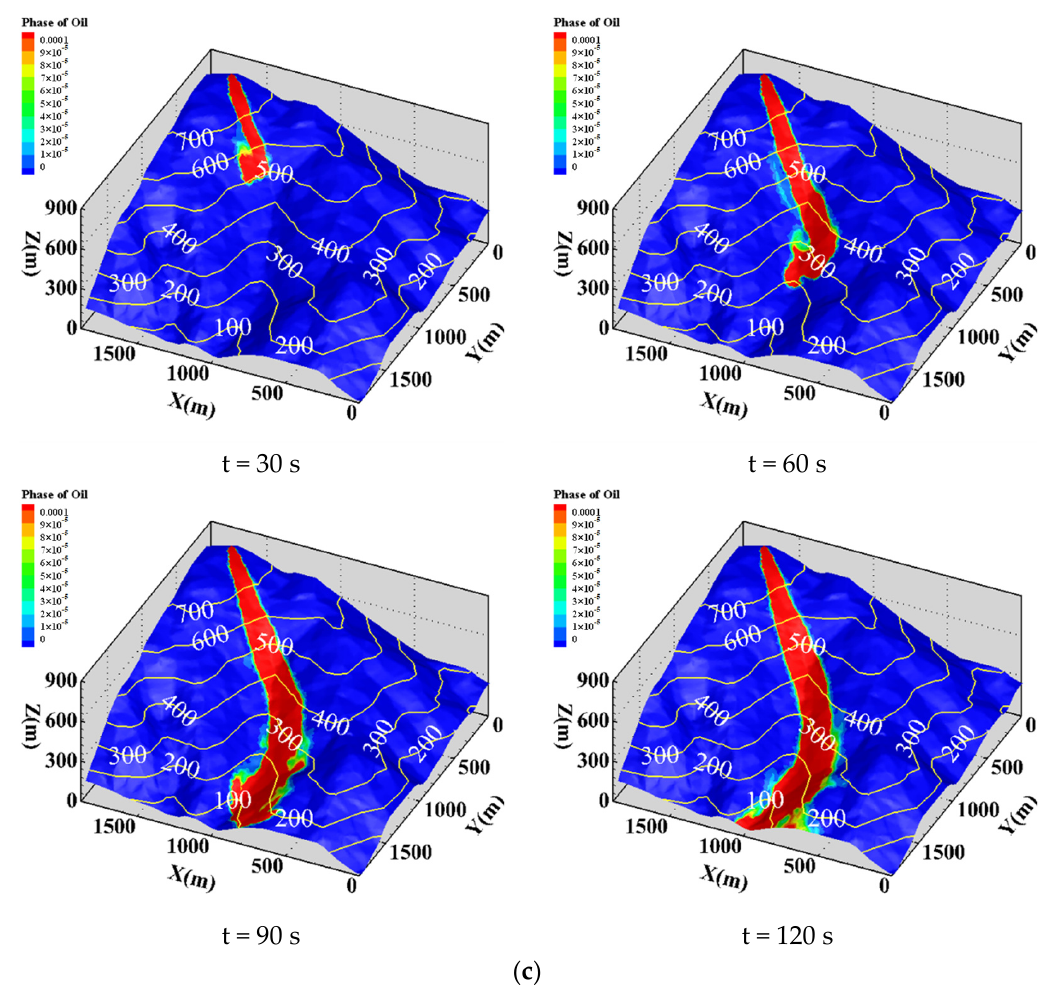
Figure 3. Crude oil diffusion patterns on smooth surface: ( a ) v =30 m/s; ( b ) v = 50 m/s; ( c ) v = 80 m/s.